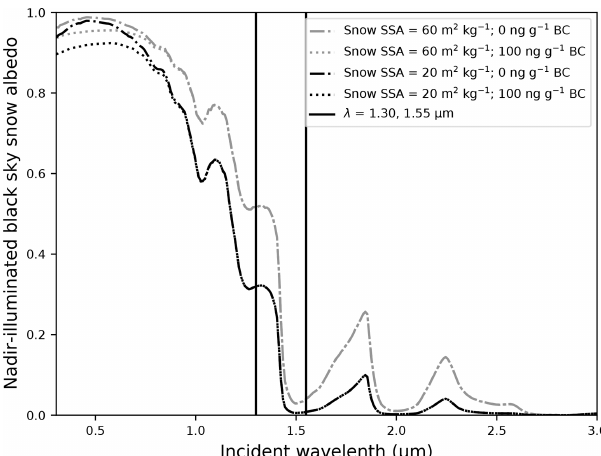
Figure 1. Black sky spectral snow albedo under nadir illumination. Snow albedo is simulated by the Snow, Ice, and Aerosol Radia- tion (SNICAR) model (Flanner et al., 2007). Dashed-dotted curves represent clean snow of medium-high SSA (60m 2 kg − 1 , gray) and medium-low SSA (20m 2 kg − 1 , black) to show the dependence of snow albedo on snow SSA. Dotted curves represent contaminated snow with uncoated black carbon (BC) particulate concentrations of 100ngg − 1